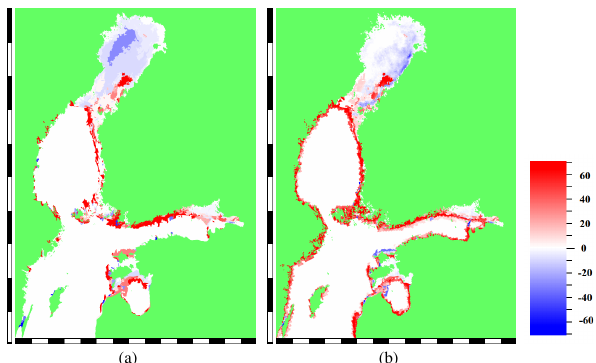
Figure 6. Difference between the algorithm result and FMI ice chart concentration for 2 February 2014 (a) and between the algorithm result and ASI concentration (b) . Overestimation produced by our algorithm with respect to the reference data is indicated by the blue tones (negative difference values) and underestimation by red (pos- itive values). In the image scales the interval is 1 ◦ in both latitude and longitude; the upper left corner is located at 66 ◦ N, 16 ◦ E, and the lower right corner is located at 56 ◦ N, 31 ◦ E.